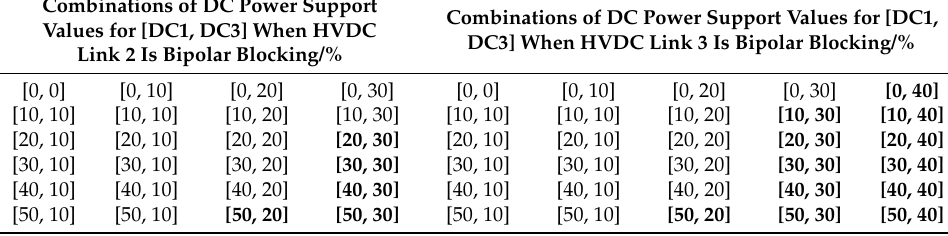
Table A3. Combinations of DC power support values when HVDC Link 2 or 3 is bipolar blocking. Combinations of DC Power Support Values for [DC1, DC3] When HVDC Link 2 Is Bipolar